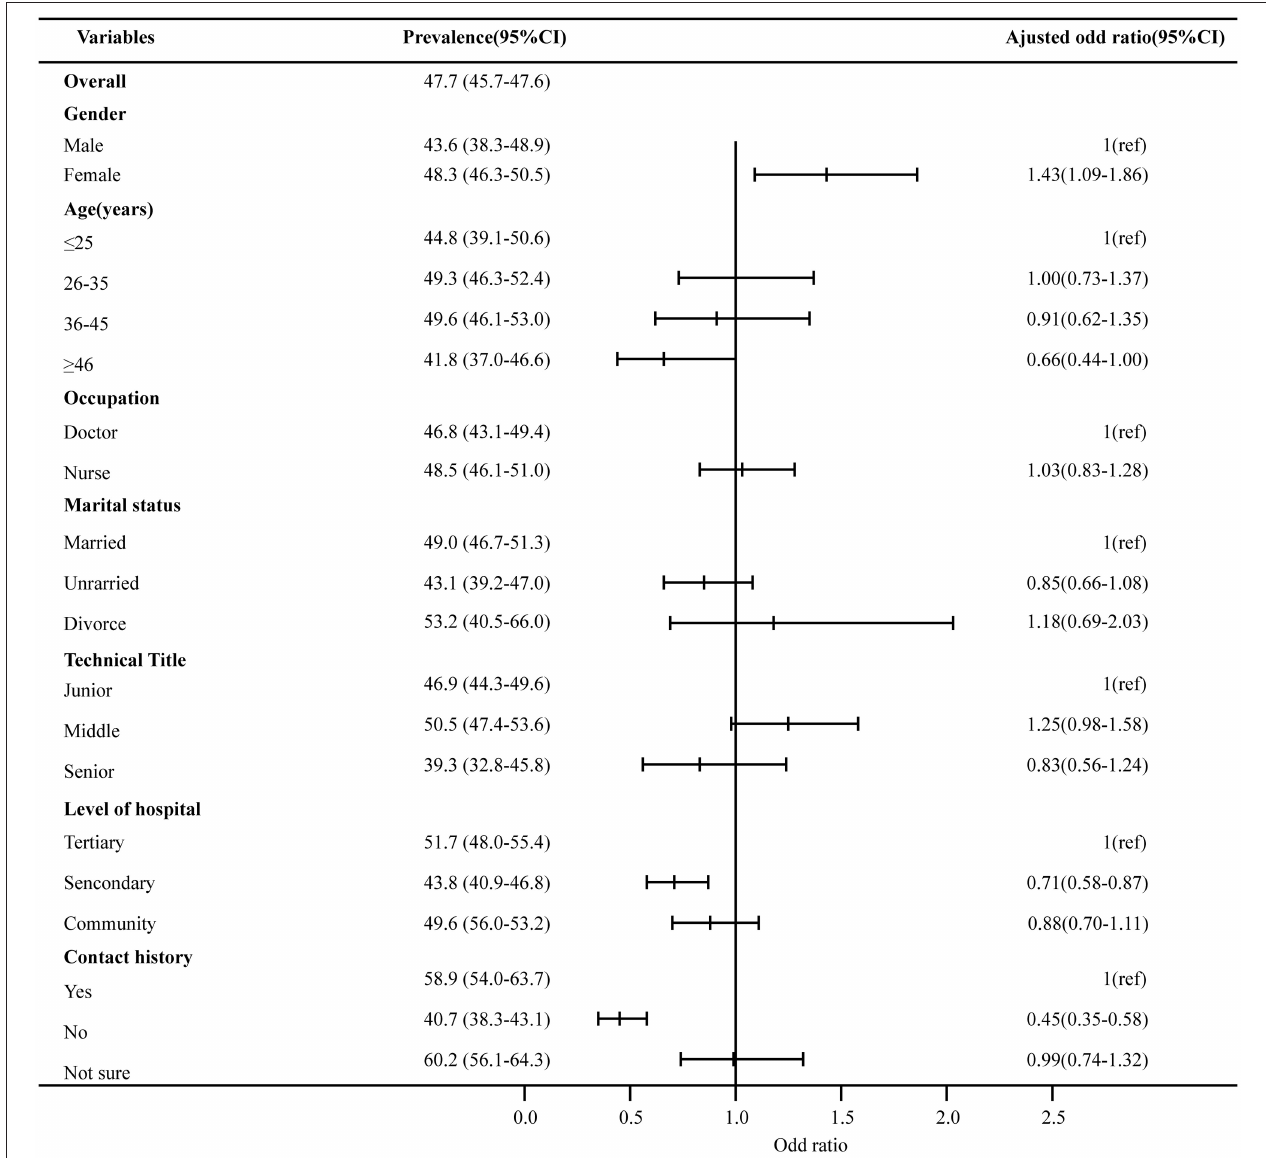
FIGURE 1 | Factors associated with the presence of psychological distress. The prevalence of psychological distress with 95% CI of independent variables is presented on the left column. Multivariate analyses were used to calculate the adjusted odds ratio of psychological distress, adjusted ORs, and their 95% CI were shown in the figures, and the numbers are given in the right column.